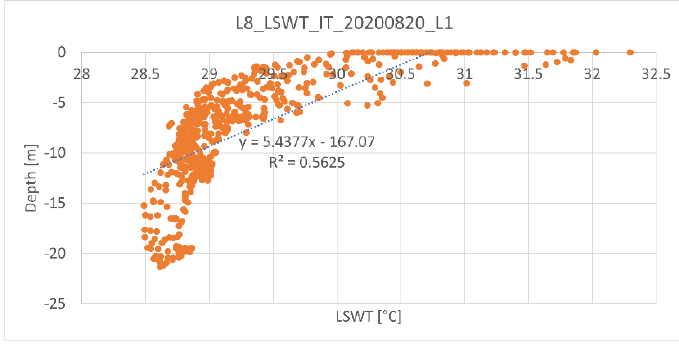
Figure 5 . Correlation between water depth and LSWT for Maggiore lake in Angera gulf (see Figure 4)